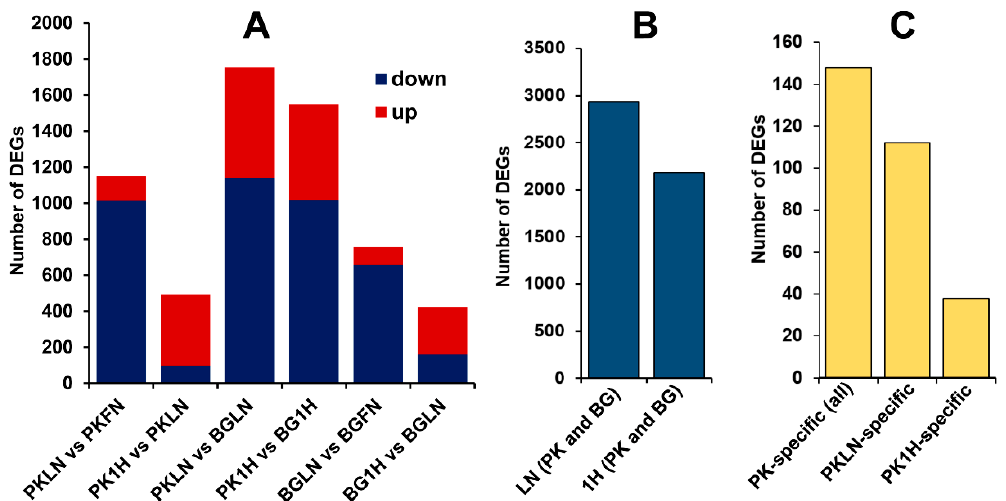
Figure 4. Venn diagrams showing differentially expressed genes (DEGs) in Pokkali and Beng al under low N stress and 1-h recovery; |log2 fold change| ≥ 2 and padj < 0.01). ( A ) Comparison of low N vs. full N, and ( B ) comparison of low N vs. 1 h after transfer to full N. Treatment groups are PKFN (Pokkali-full nitrogen), PKLN (Pokkali-low nitrogen), PK1H (Pokkali 1 h after transfer from low N to full N), BGFN (Bengal-full nitrogen), BGLN (Bengal-low nitrogen), and BG1H (Bengal 1 h after transfer from low N to full N).